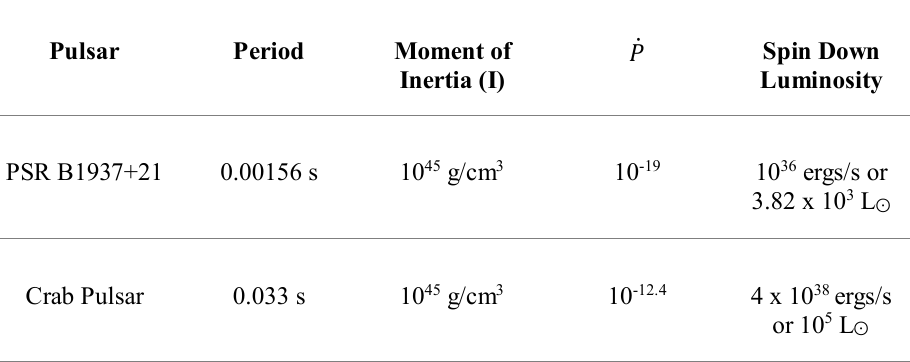
Table 3 . Comparison of the PSR B1937+21 and Crab